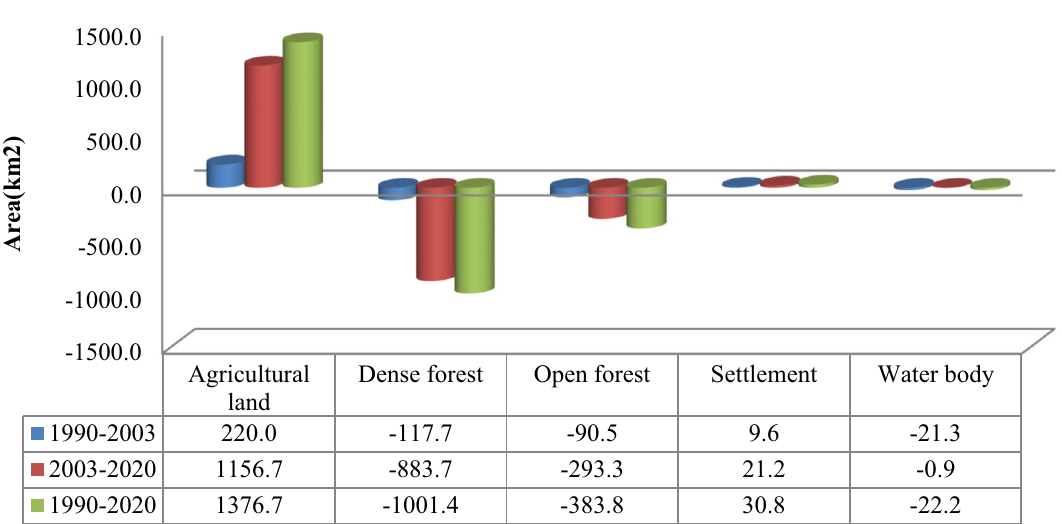
Fig. 5 Trends of LULC in the study